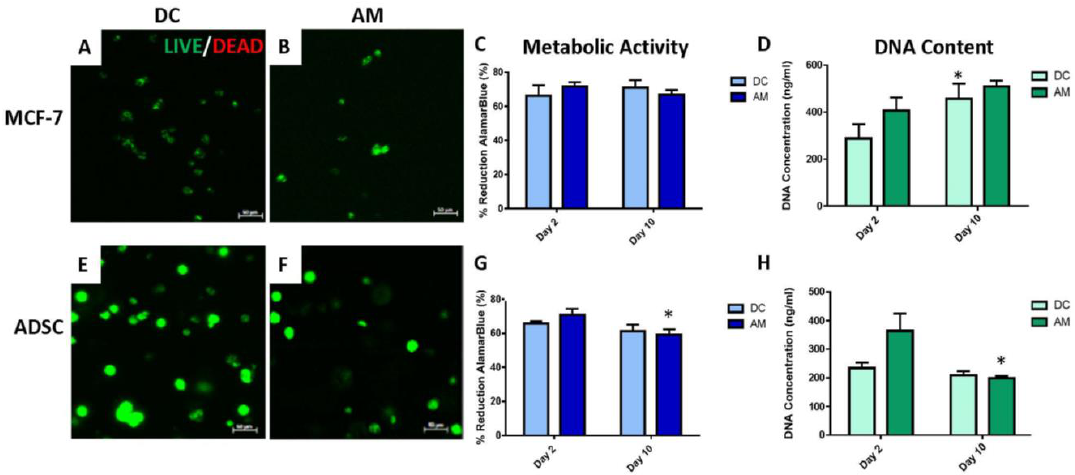
Figure 6. 3D monoculture assesment of MCF-7 and ADSC cell-laden hydrogels in DMEM-Complete and adipogenic maintenance media. ( A , B , E , F ) LIVE / DEAD ® images. ( C , D , G , H ) AlamarBlue ® and PicoGreen ® quantification of metabolic activity and cell viability. Scale bar = 50 µm.